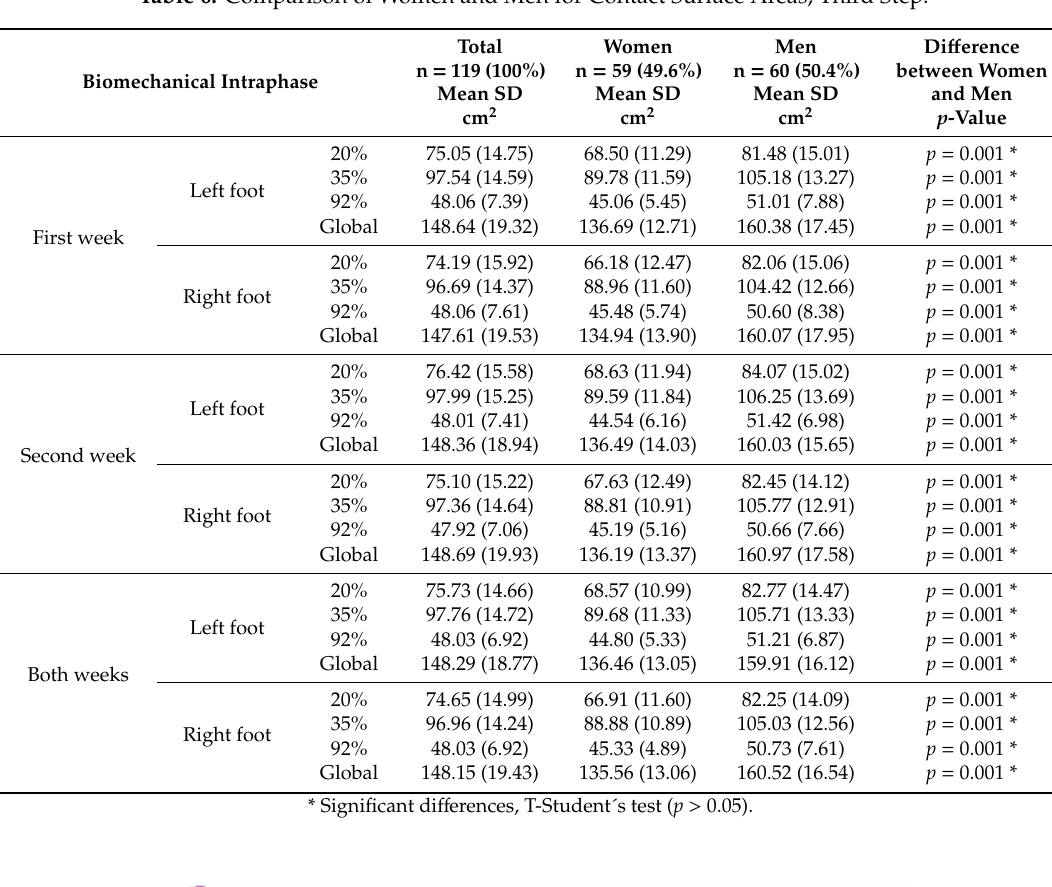
Table 6. Comparison of Women and Men for Contact Surface Areas, Third